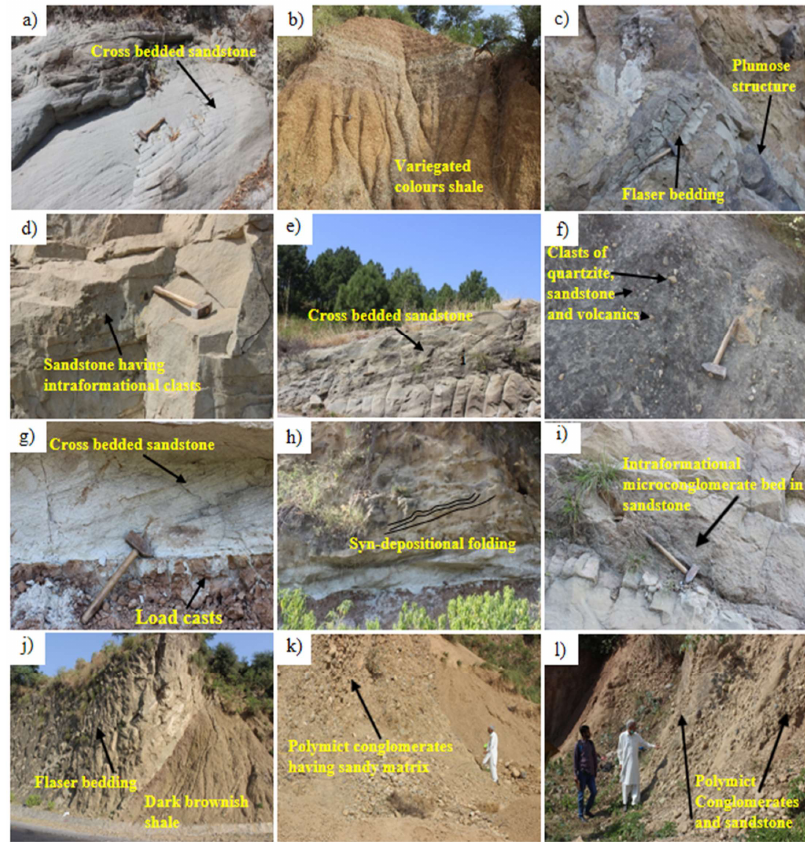
Figure 4. Photograph showing ( a ) fine-grained ash grey cross-bedded sandstone of Chinji Formation; ( b ) variegated coloured shale of Chinji Formation; ( c ) flaser bedding and plumose structure in Nagri Formation; ( d ) intraformational clasts in sandstone of Nagri Formation; ( e ) cross bedding in sandstone; ( f ) clasts of volcanic, quartzite and sandstone; ( g ) cross bedding and load casts; ( h ) syn-depositional folding; ( i ) intraformational microconglomerate bed in sandstone; ( j ) flaser bedding and dark brownish shale; ( k ) conglomerate and shale of Soan Formation; ( l ) polymict conglomerate and sandstone of Soan Formation.